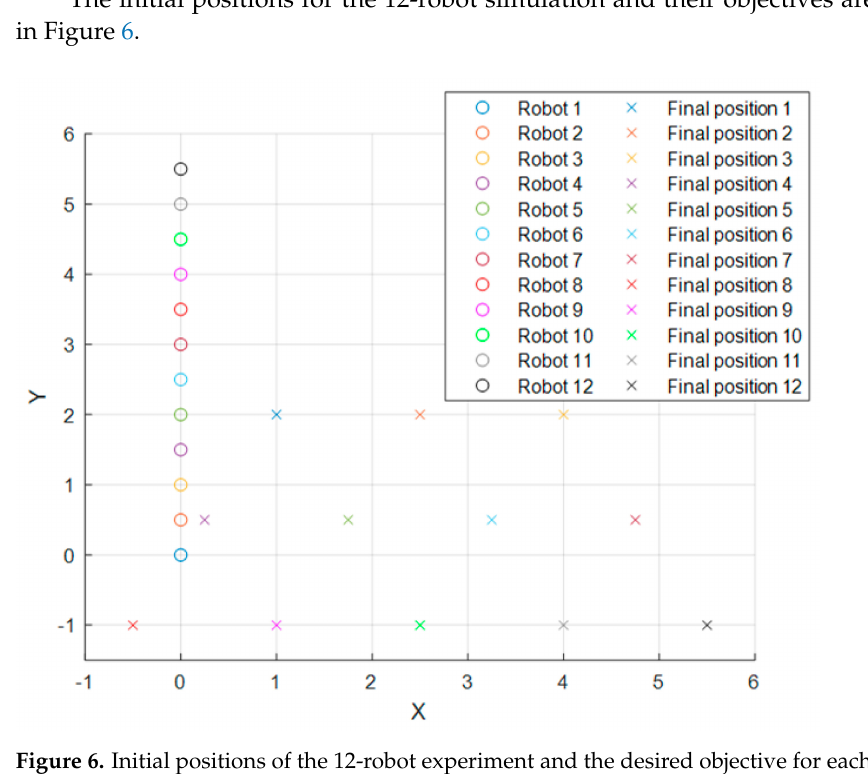
Figure 6. Initial positions of the 12-robot experiment and the desired objective for each